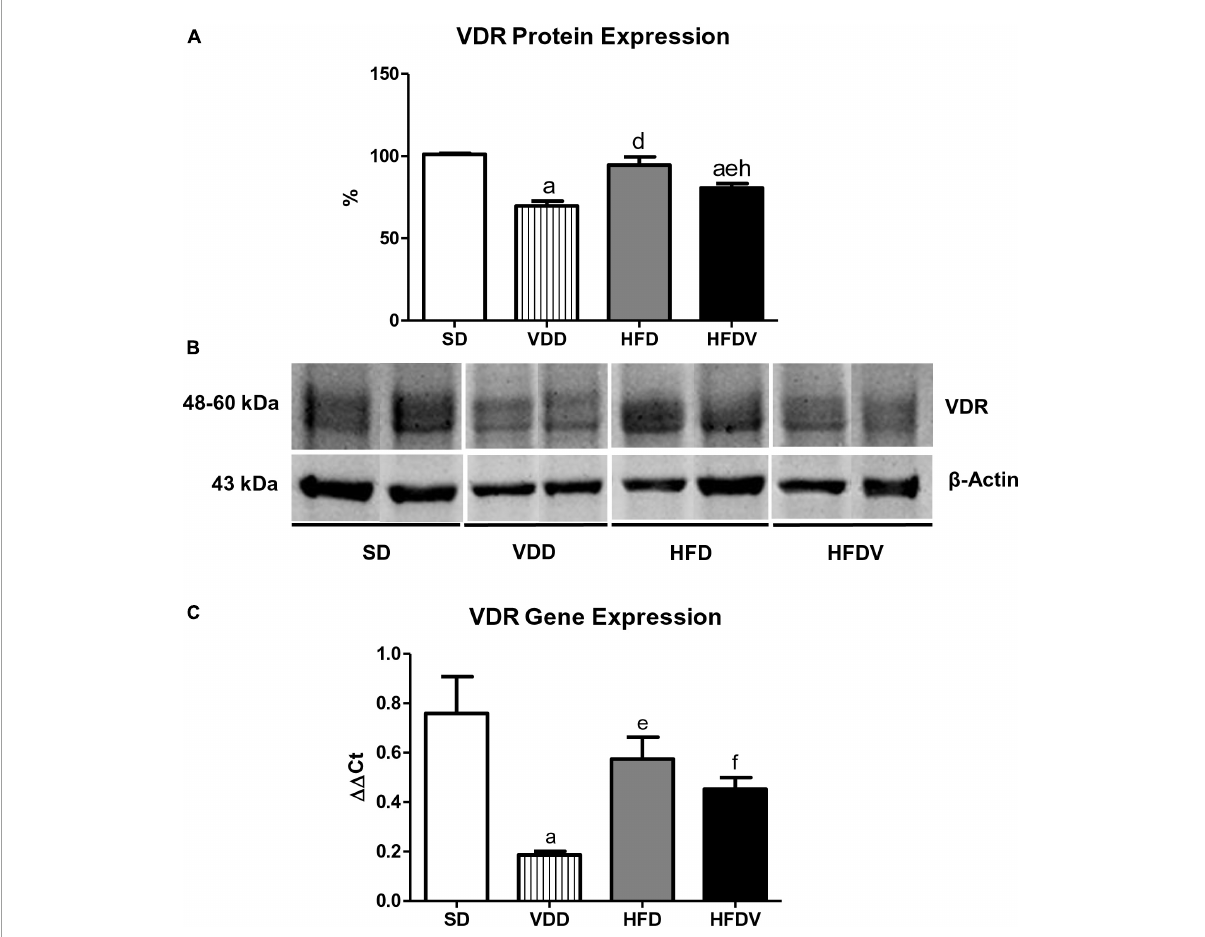
FIGURE4 Semiquantitative immunoblotting for renal vitamin D receptor (VDR) protein expression and RT qPCR for adipose tissue VDR gene expression evaluated after the 90-day protocol in rats submitted to renal ischemia-reperfusion insult on day 45 treated with standard diet (SD), vitamin D-free diet (VDD), high-fat diet (HFD), or high-fat vitamin D-free diet (HFDV). (A) Densitometric analysis of samples from an SD, VDD, HFD, and HFDV rat. (B) Representative immunoblots reacted with anti-VDR revealing a 51 kDa band. (C) Bar graph of VDR gene expression values. Data are mean ± SEM. a p < 0.001 vs . SD; d p < 0.001, e p < 0.01 and f p < 0.05 vs. VDD; h p < 0.01 vs . HFD.